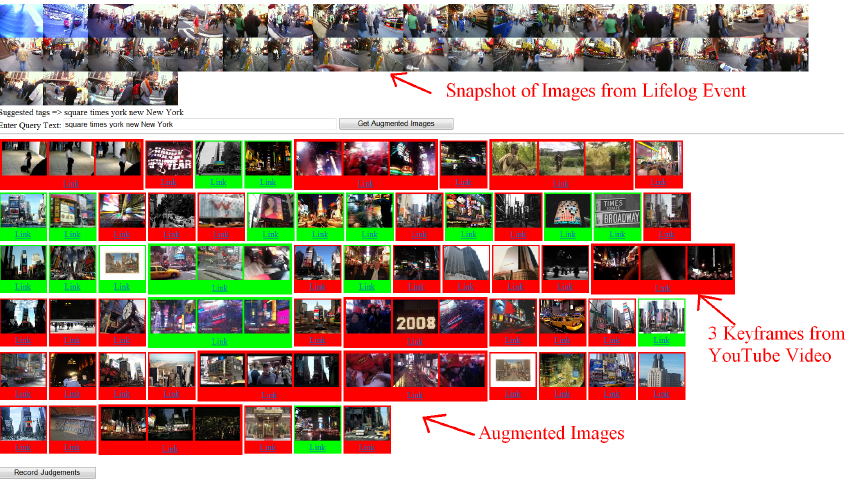
Figure 9. Judging results for event